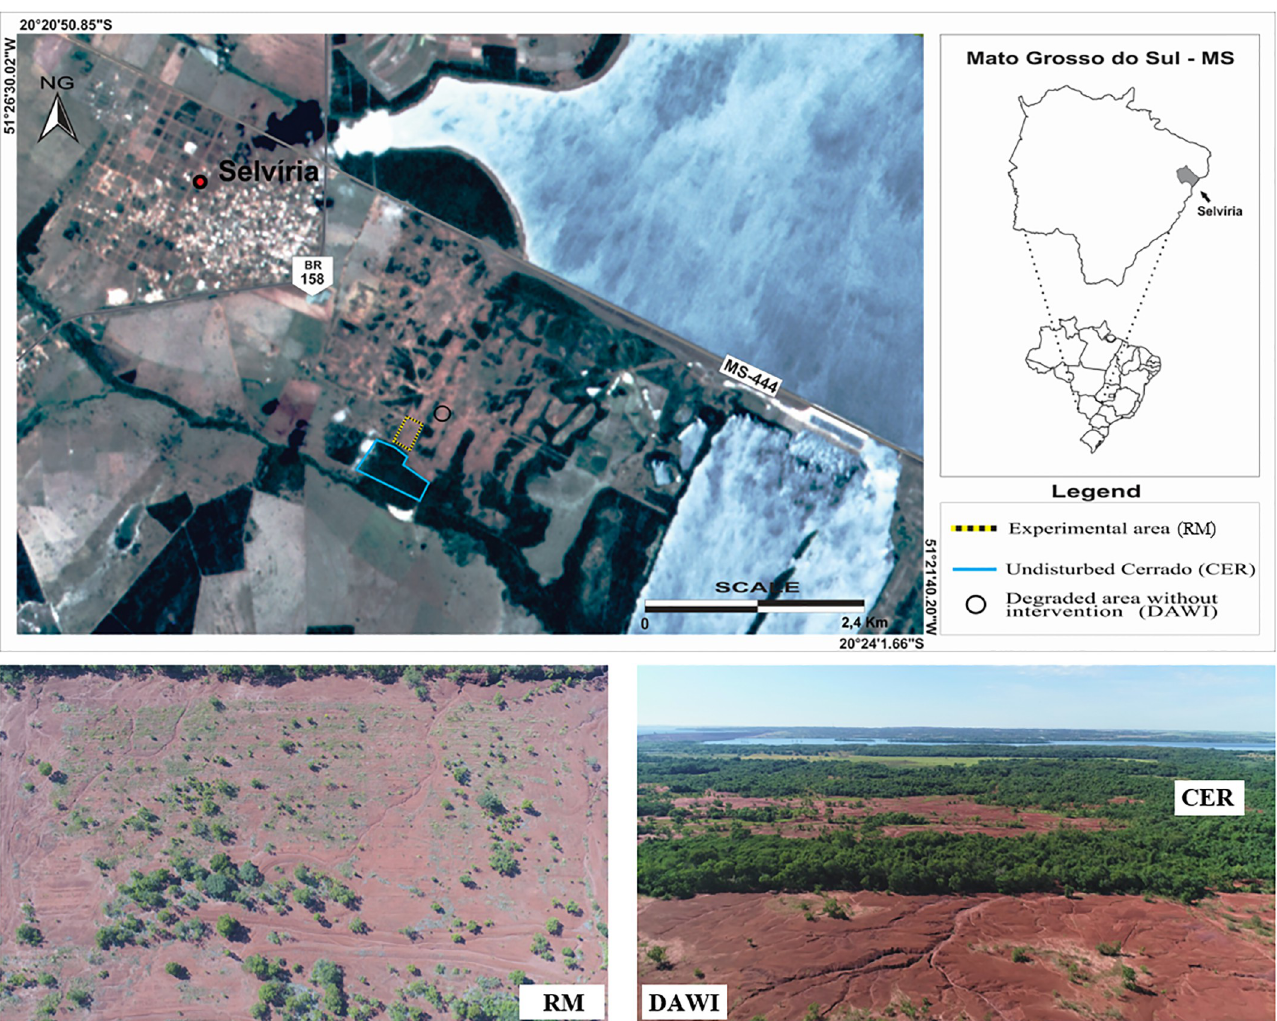
Fig 1. Aerial view of the research site illustrating the degraded area without intervention (DAWI, black circle), the area under restoration management (RM; dotted rectangle), and the undisturbed Cerrado (CER; solid blue polygon) in Selvı´ria, Mato Grosso State, Brazil.